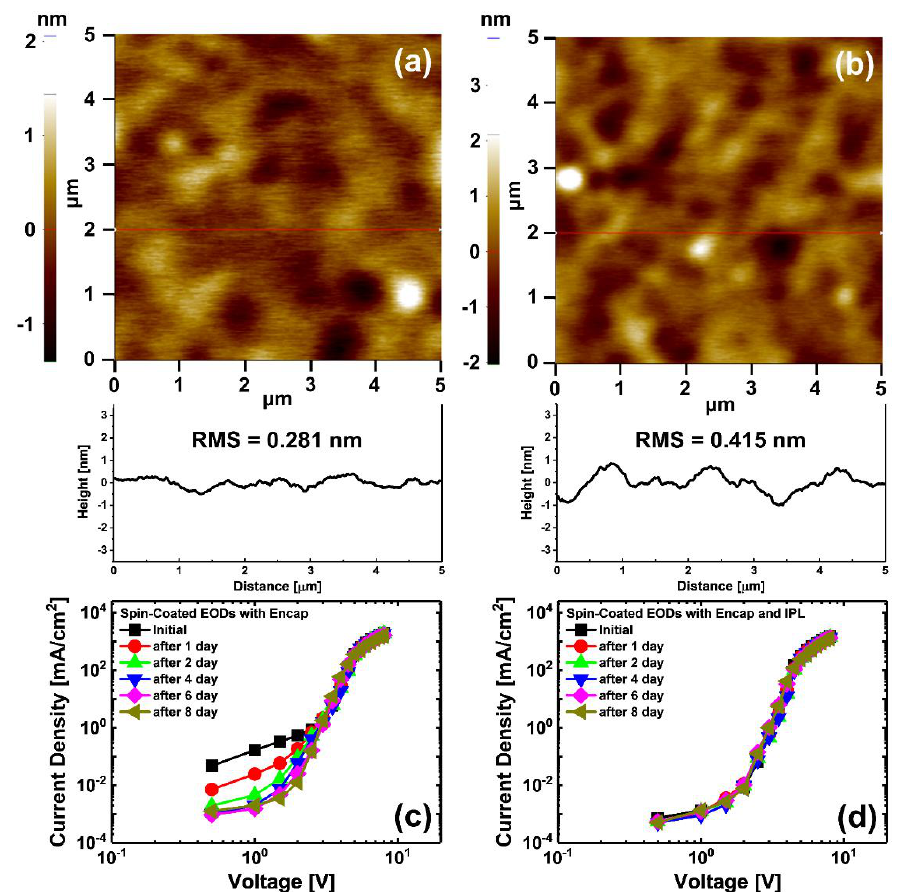
Figure 3. Atomic force microscope (AFM) images and line profiles of the spin-coated ZnO NPs film surface ( a ) without and ( b ) with IPL post-treatment. Current density characteristics of electron-only devices (EODs) ( c ) without and ( d ) with IPL post-treatment.